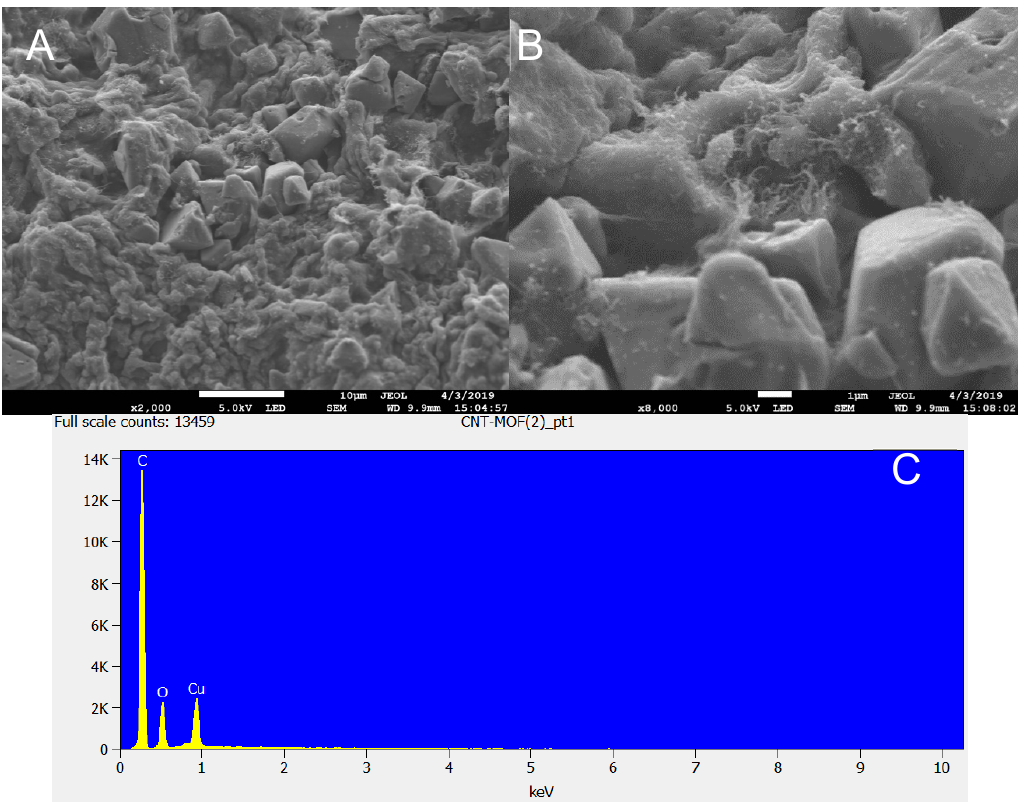
Figure 3. (A) SEM image of FMWCNT/HKUST-1 composite, (B) High resolution image of FMWCNT/HKUST-1 composite, (C) EDS image of FMWCNT/HKUST-1 composite.